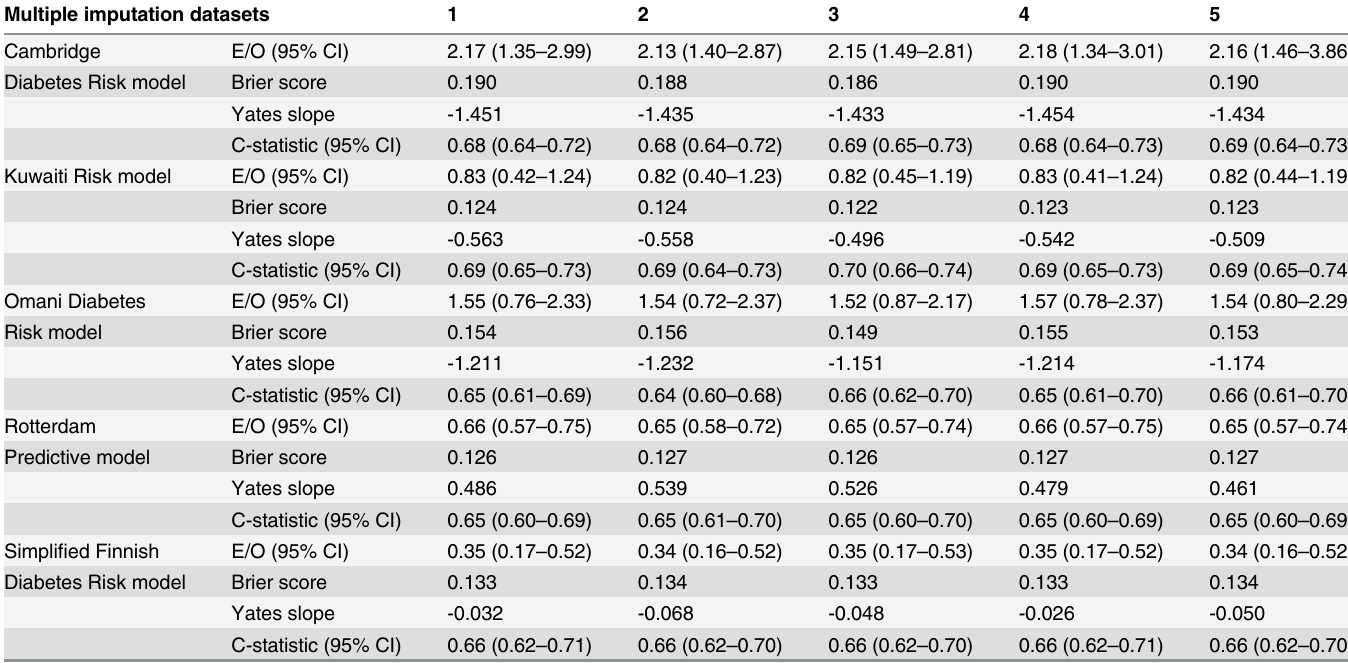
Table 5. Overview of the performance of the undiagnosed diabetes risk prediction models across the five multiple imputation datasets. Multiple imputation